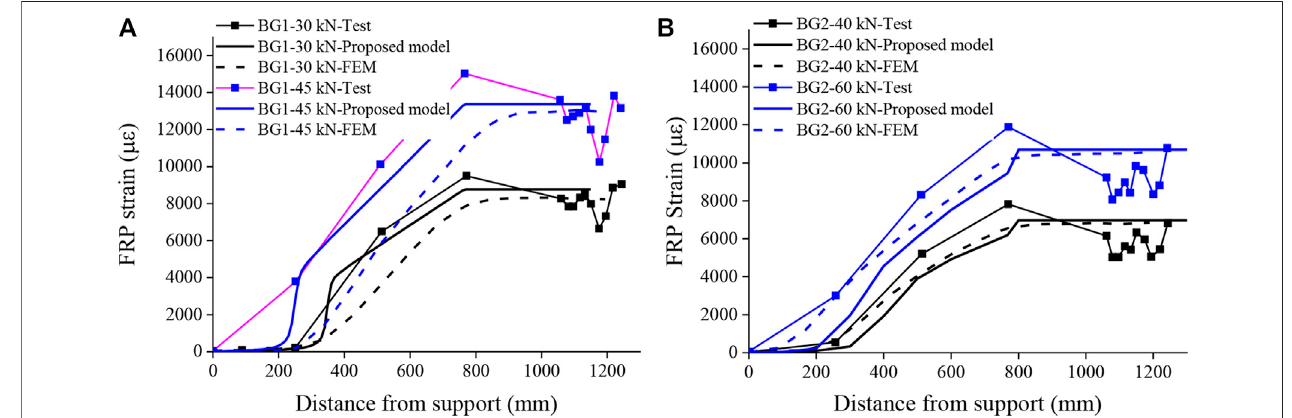
FIGURE 6 | FRP strain along the length of (A) BG1 and (B) BG2.